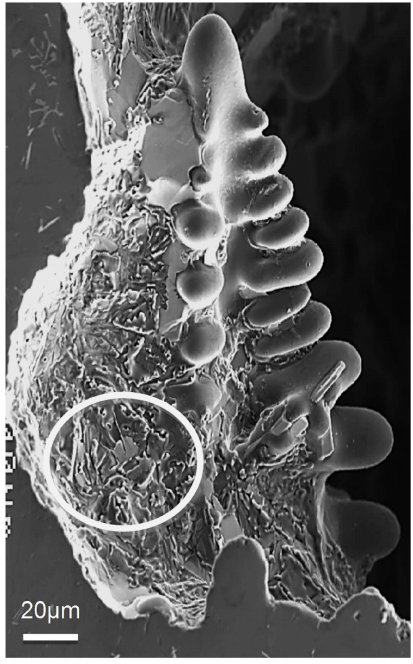
Figure 3. General view for the morphology of the eutectic Si particles in A1B alloy, DAS ~ 25 µ m. The circled area shows thin flaky Si particles with rounded